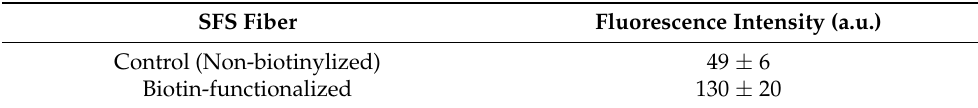
Figure 4. Fluorescence micrographs of ( 1 ) Yarn of fibers functionalized with alkyne and incubated with fluorescein-azide. ( 2 ) Yarn of control fibers (non-functionalized with alkyne) incubated with fluorescein-azide. The insert in Figure ( 2 ) shows the bright field optical micrograph of the fibers, due to the low fluorescence observed in the control fibers. The fluorescence of the micrographs is quantified in Table 4. Table 4. Comparison of the fluorescence observed on fibers functionalized with alkyne and incubated with fluorescein-azide and control (non-functionalized) fibers incubated with fluorescein-azide. Two micrographs were taken from different regions of the fiber and at least three measurements of fluores- cence intensity were obtained from each micrograph. Values are expressed as mean ± standard